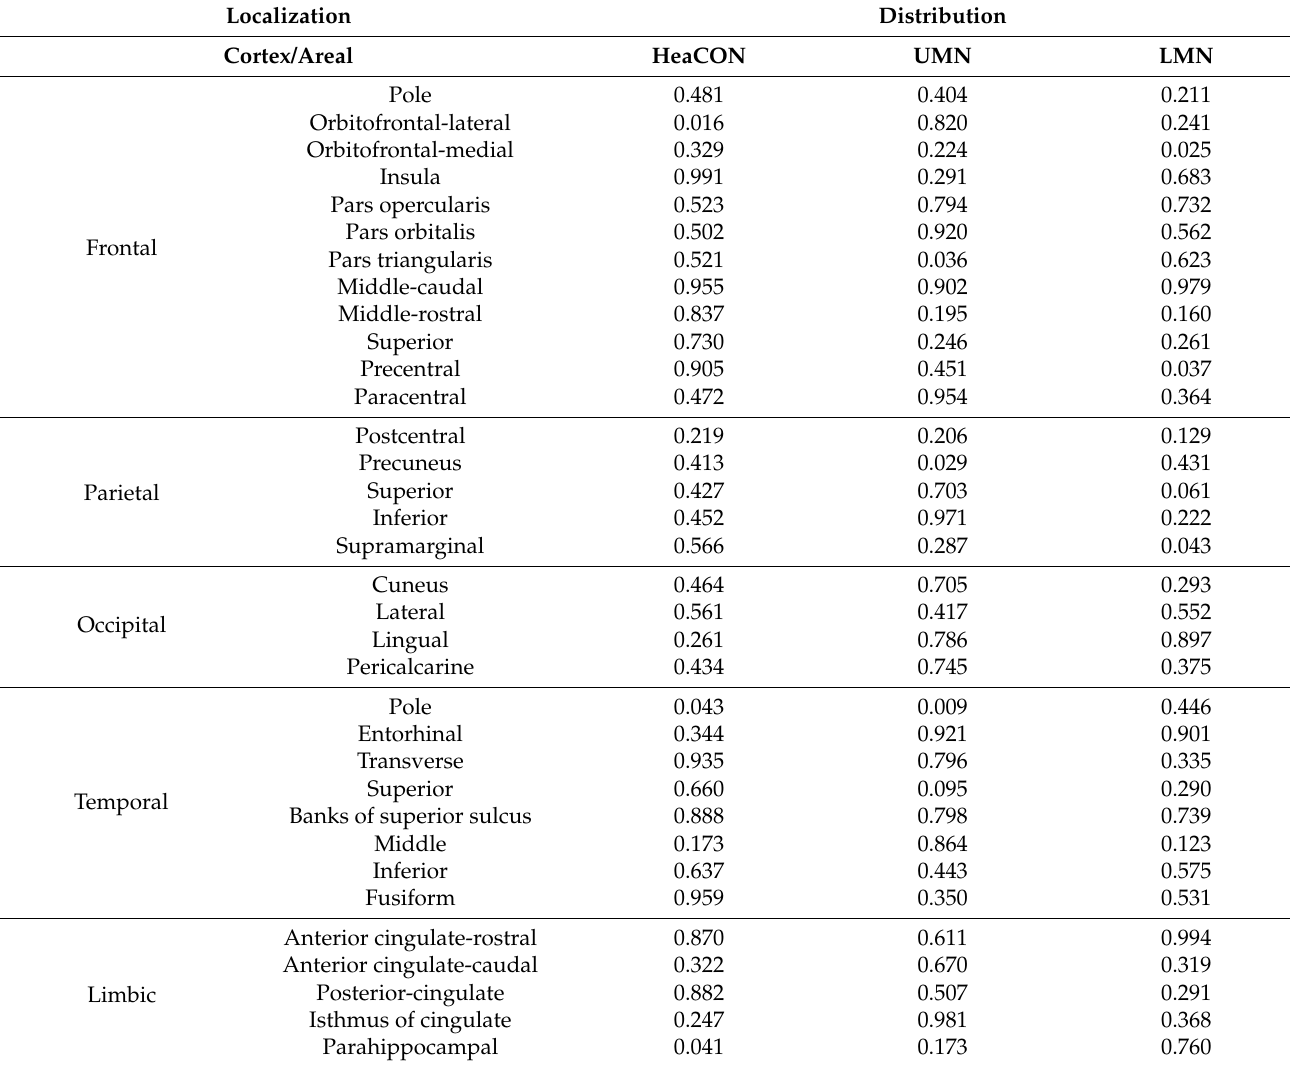
Table 1. Normality distribution of cortical thickness within regions of interest. Results from the Shapiro–Wilk test for the normality distribution for each ROI in the left hemisphere per group. Values below 0.05 indicate non-normally distributed data. HeaCON, healthy controls; LMN, lower motor neuron patients; UMN, upper motor neuron